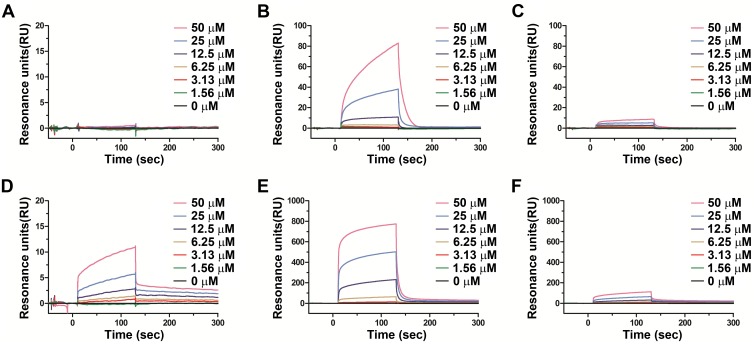
Surface plasmon resonance analysis.(A, B and C) SPR analysis of serial dilutions of PRM-A from 1.56 to 50 μM exposed to the parental Tb BSF VSG221 bound at low density (826 RU) (A) or high density (6,500 RU) (B) and to the PRM-A100-resistant cell line VSG221 bound at high density (6,070 RU) (C) on a CM5 sensor chip. (D, E and F) SPR analysis of serial dilutions of PRM-S using the same conditions as described above.